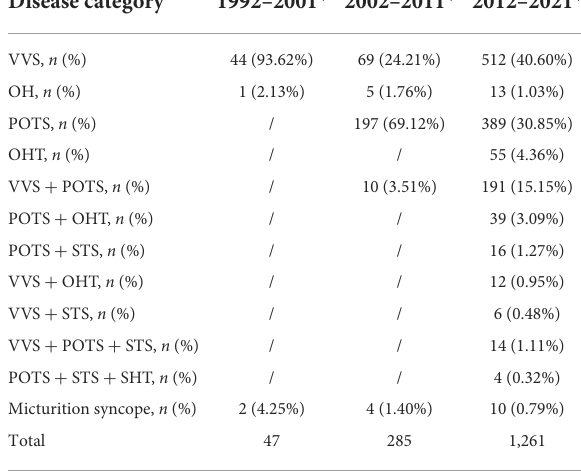
TABLE 2 Changes in neurally-mediated syncope spectrum over three